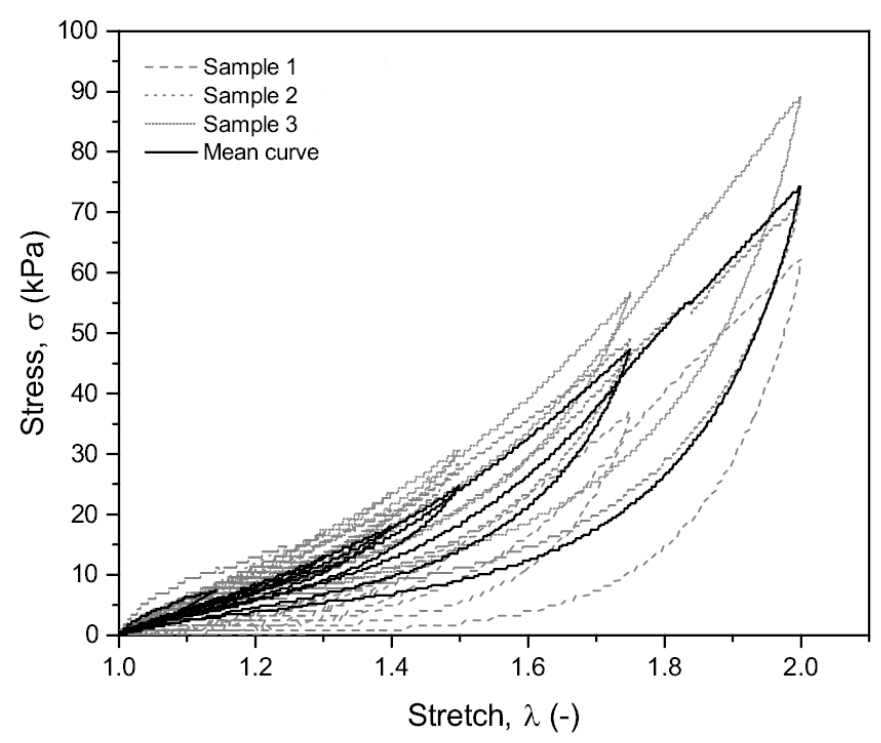
Figure 7. Experimental results and mean curve corresponding to the circumferential samples from porcine